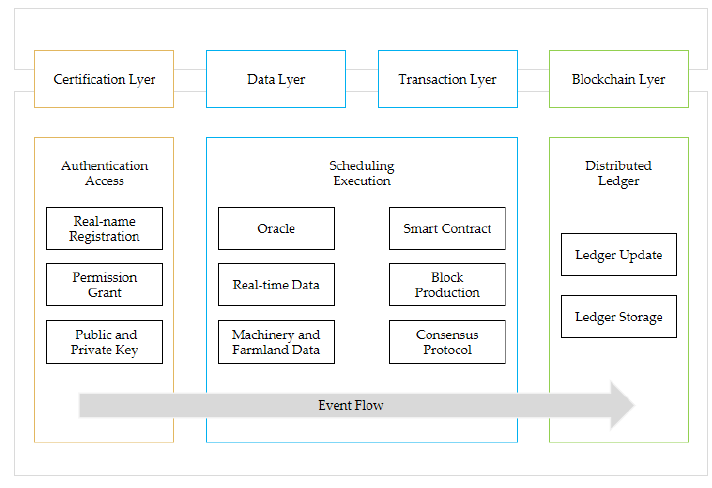
Figure 1. System composition. Table 2.